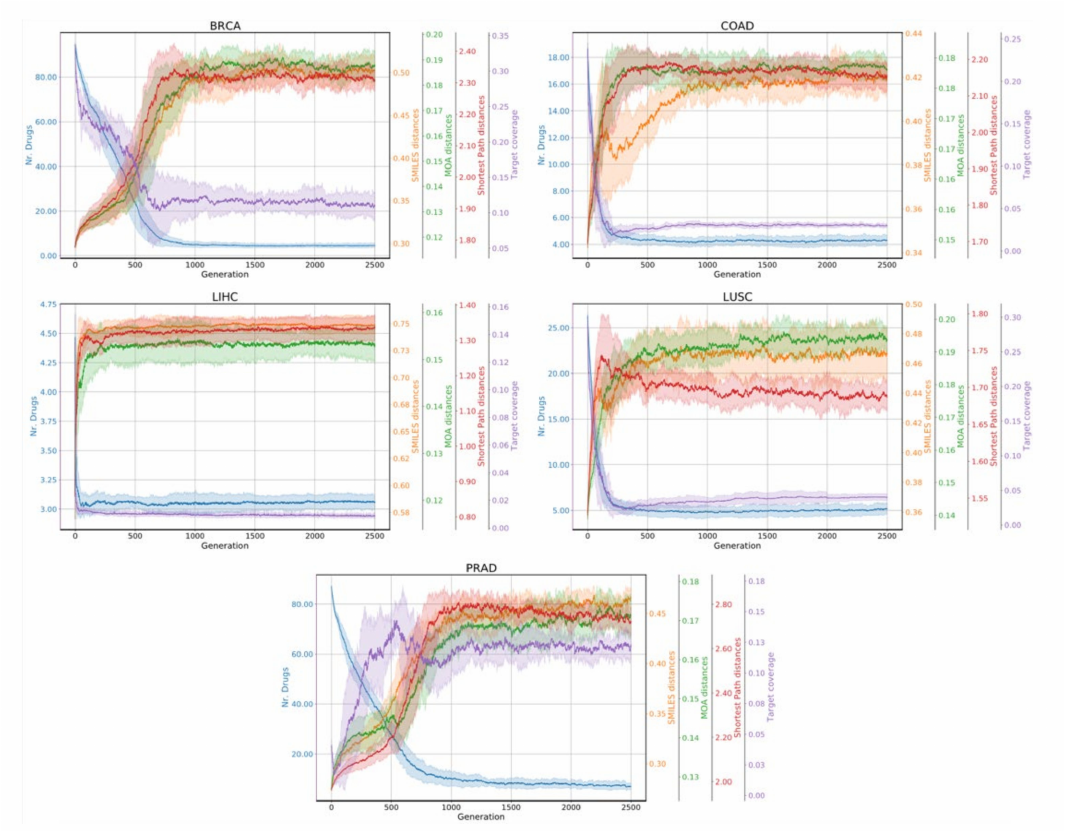
Figure 4. Trace plots showing the performance of the genetic algorithm in terms of stability of the obtained drug combinations. The color of the traces indicate the objective function that is optimized in the genetic